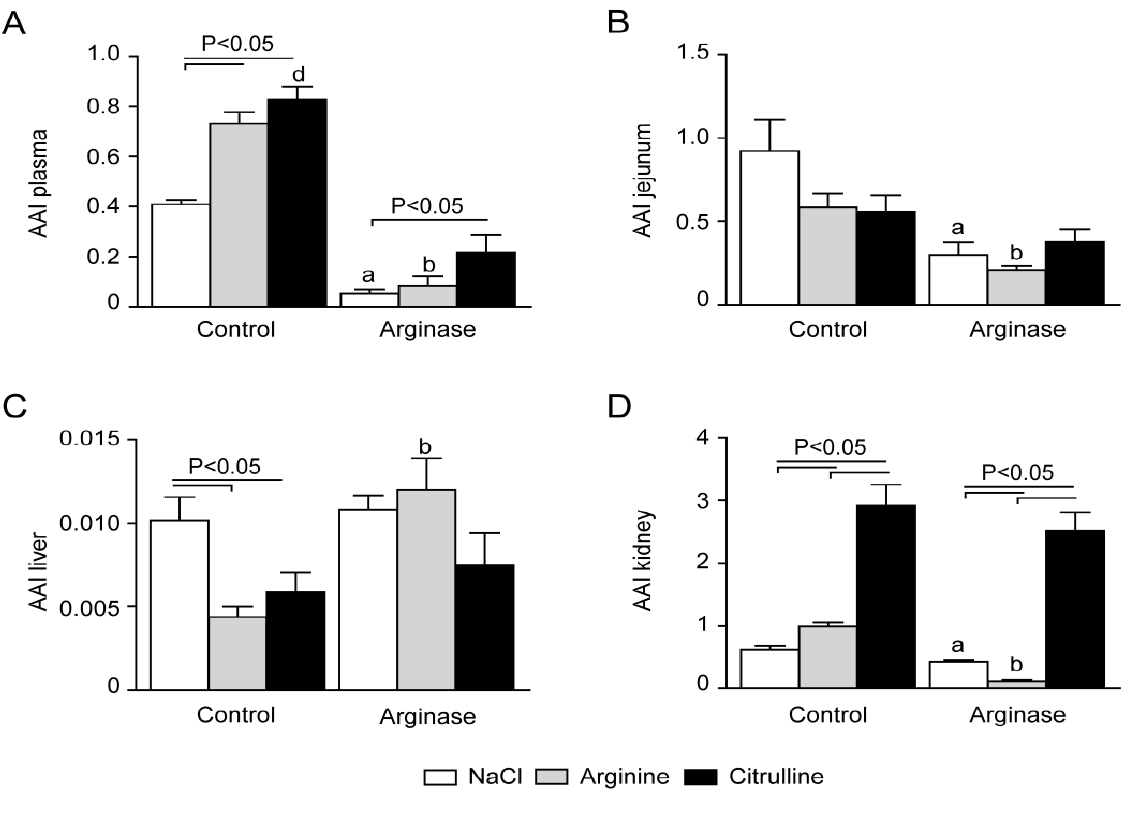
Figure 7. Plasma and tissue arginine availability in control and arginase-treated animals with L -arginine or L -citrulline supplementation. Arginine arginine availability index (AAI; (arginine)/((lysine)+(ornithine))) measured in plasma ( A ), jejunal tissue ( B ), liver ( C ) and renal tissue ( D ) of control and arginase-treated animals with or without supplemented L -arginine or L -citrulline. Significance: a p < 0.05 vs. control; b p < 0.05 vs.